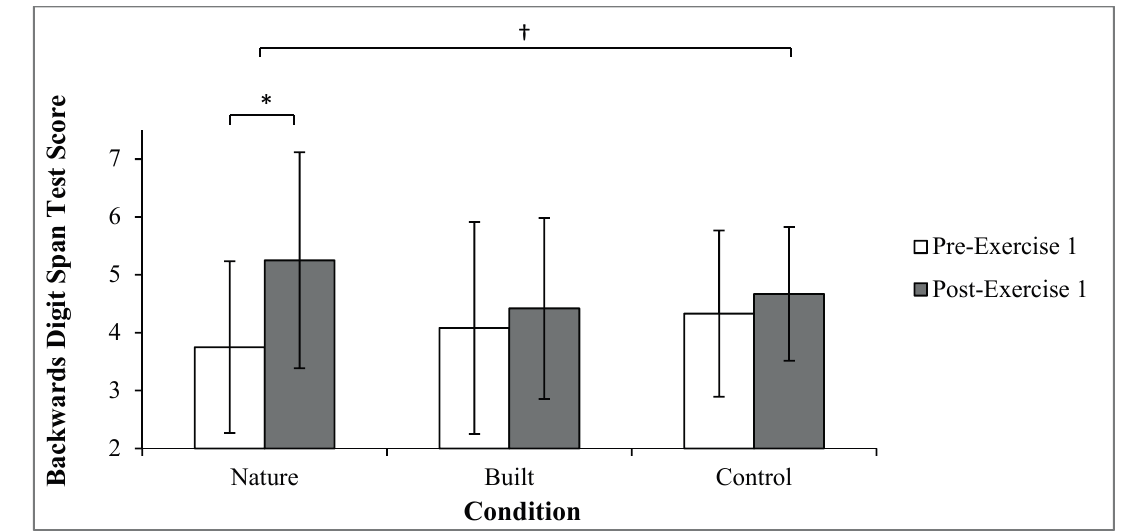
Figure 1. Mean (±SD) pre- and post- Exercise 1 Backwards Digit Span test scores by condition; Higher score represents greater level of directed attention; * , pre- and post- Exercise 1 values significantly differ ( p = 0.001); † , significant time by condition interaction ( p = 0.007).